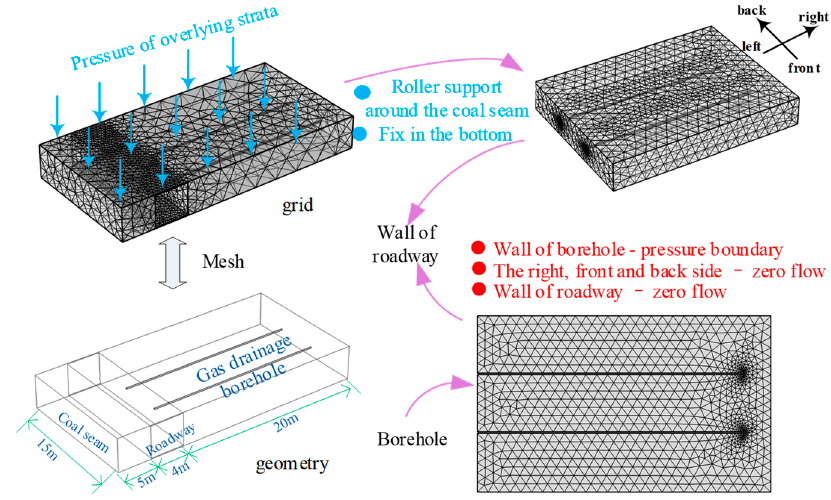
Figure 5. The establishment of the tunnel and borehole cross model.